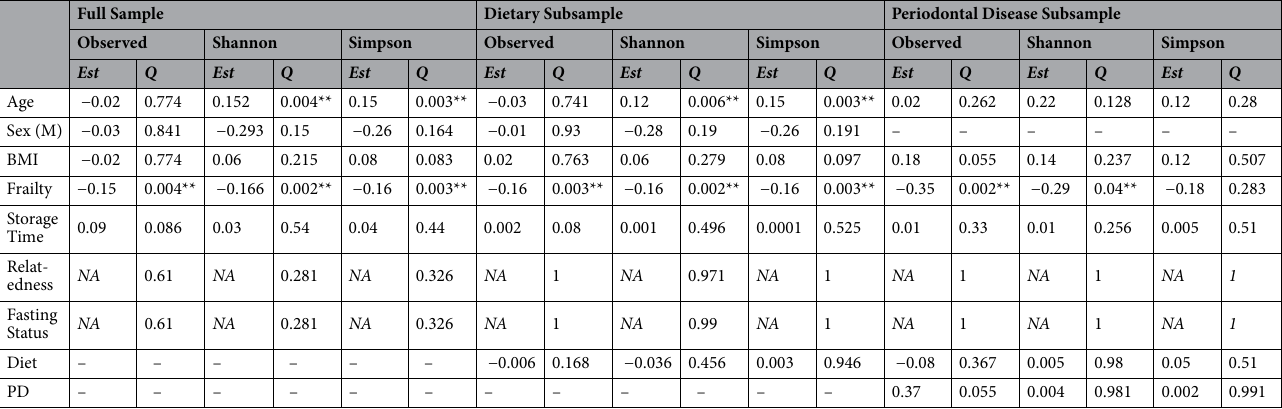
Table 2. Association with saliva microbiota alpha diversity of potential influential factors. Multivariate models are presented for each sample: full sample, dietary sub-sample, and periodontal disease subsample. All models are adjusted for multiple testing and resultant Q values are given. Full sample (n = 679): in a multivariate model adjusting for all other variables listed (not including diet or periodontal disease), factors